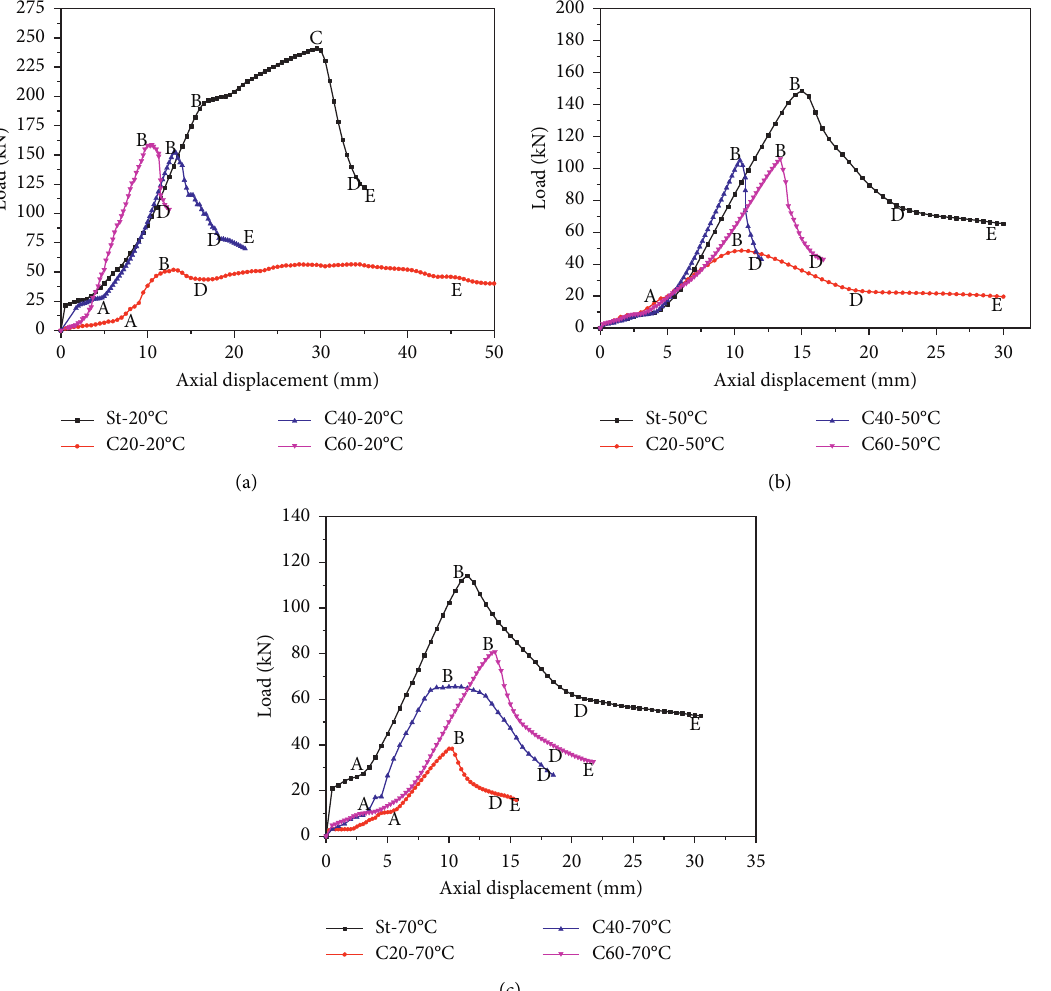
Figure 7: Relationship between drawing force and displacement. (a) Pull-out specimens in 20 ° C. (b) Pull-out specimens in 50 ° C. (c) Pull-out specimens in 70 °